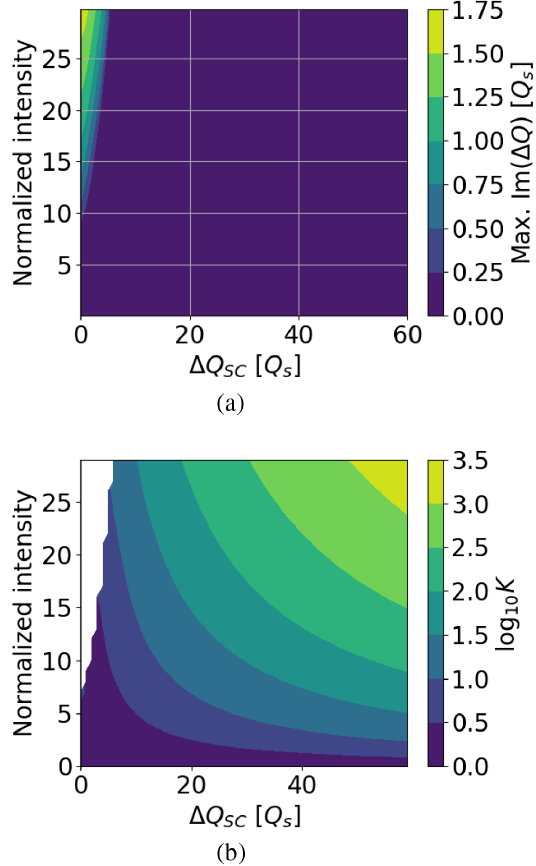
FIG. 4. Maximum tune shift (above) and the Kreiss constant (below) obtained for an airbag distribution for various strength of space charge forces and wakefields. The Kreiss constant becomes infinite for configurations featuring unstable eigenvalues which is marked by a white area. (a) Maximum tune shift (b) Kreiss constant.